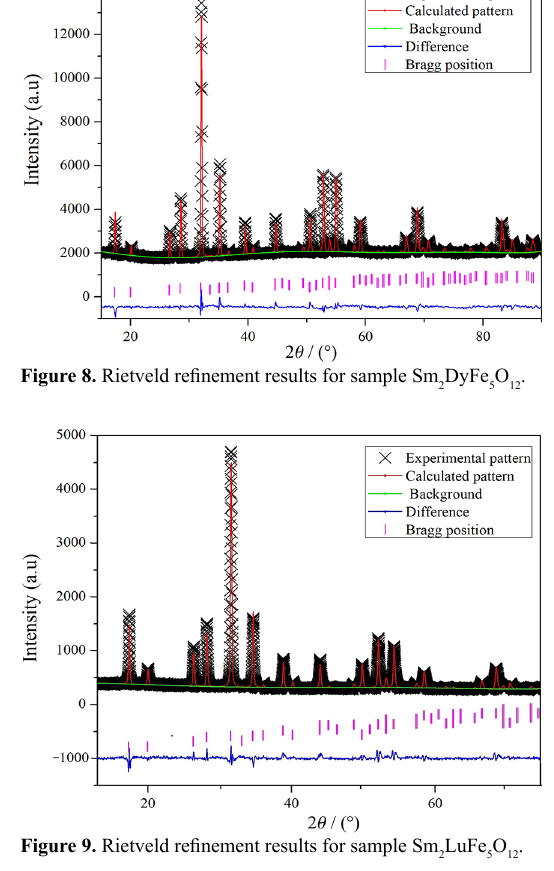
Figure 9. Rietveld refinement results for sample Sm The synthesis method used in comparison to chemical methods, does not generate polluting gases or any type of by-product, due to it does not require the use of solvents. Also, the method allows to obtain materials with higher crystallinity.